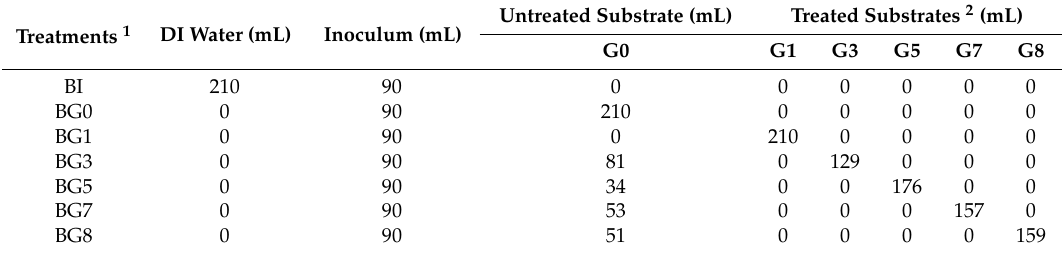
Table 5. Biochemical methane potential (BMP) assay of struvite precipitation (SP) treated substrates.